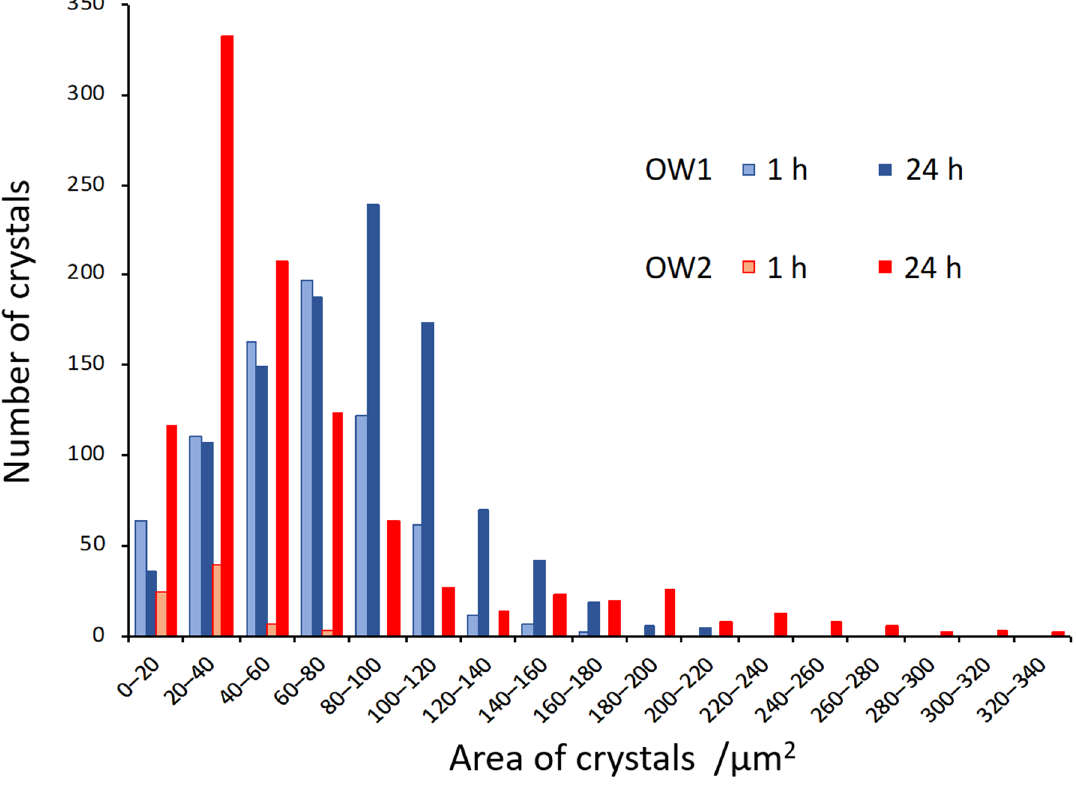
Figure 3. Distributions of the crystal dimension in CaOx suspensions obtained by mixing calcium chloride and sodium oxalate solution and prepared using OW1 or OW2 as solvent. Samples were left at rest for 1 h or 24 h.